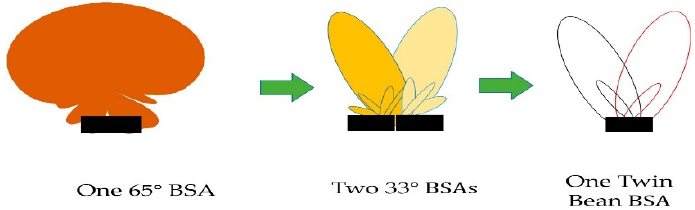
Figure 2. Single-beam BSA, two narrow-beam BSAs, and a twin-beam BSA